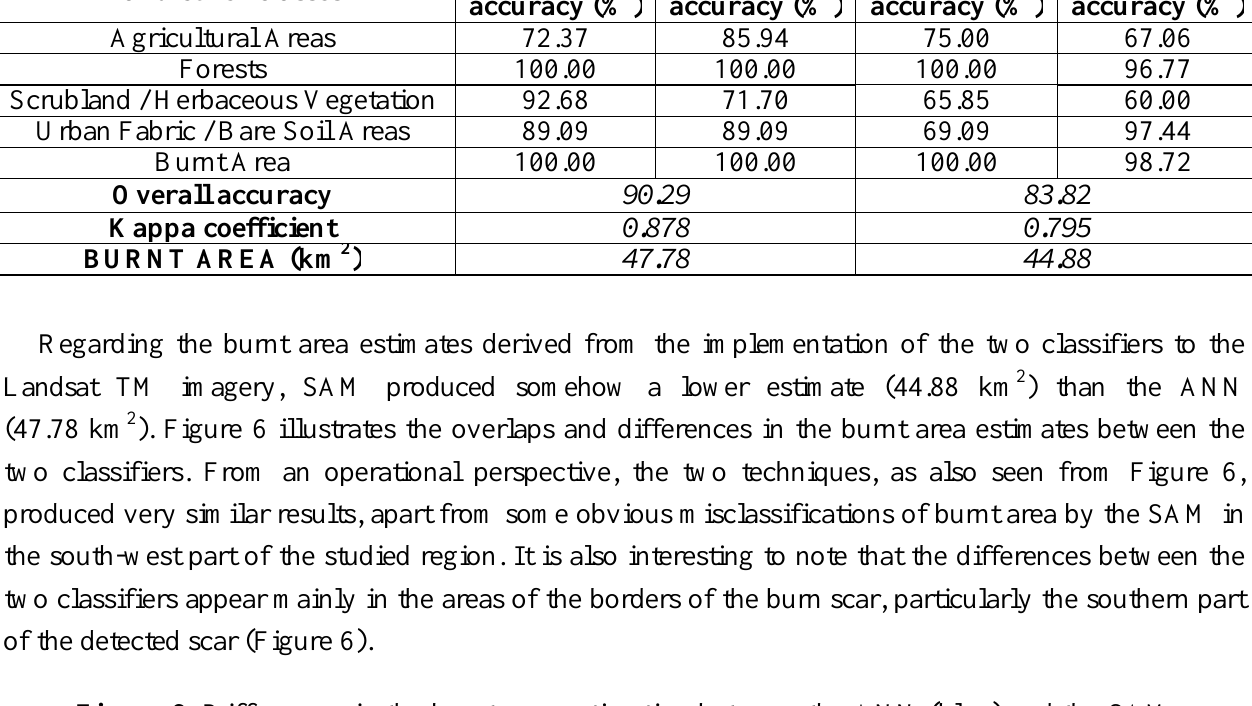
Figure 6. Differences in the burnt area estimation between the ANN (blue) and the SAM (green)